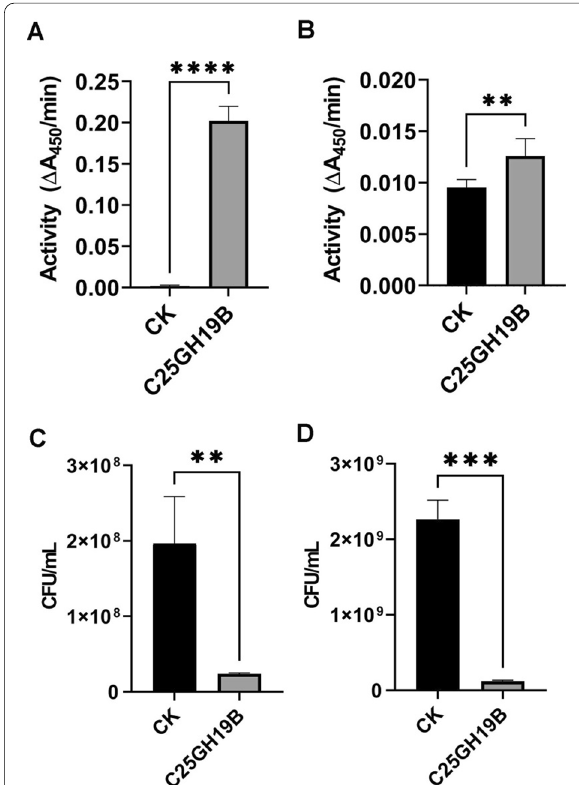
Fig. 5 Bacteriolytic activity of C25GH19B against C. flaccumfaciens and P. syringae . A and B Lytic activity of C25GH19B on lyophilized C. flaccumfaciens and P. syringae , respectively. C and D Plate count assays for the antimicrobial activity of C25GH19B on freshly cultured C. flaccumfaciens and P. syringae , respectively. **p < 0.01; ***p < 0.001; ****p <